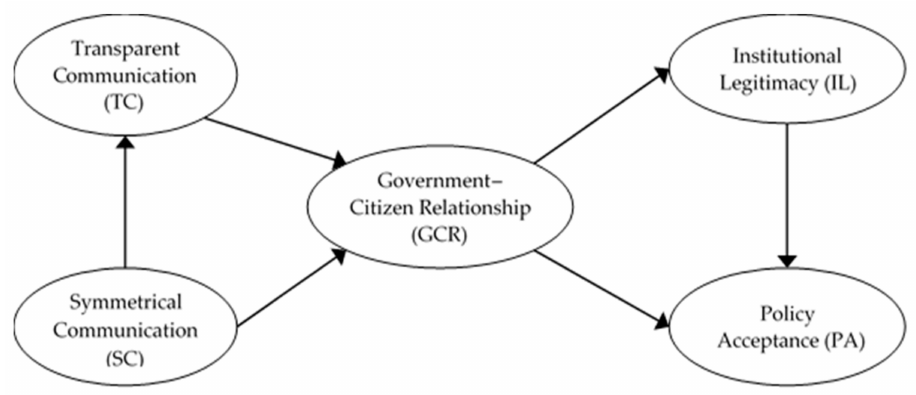
Figure 1. Hypothesized research